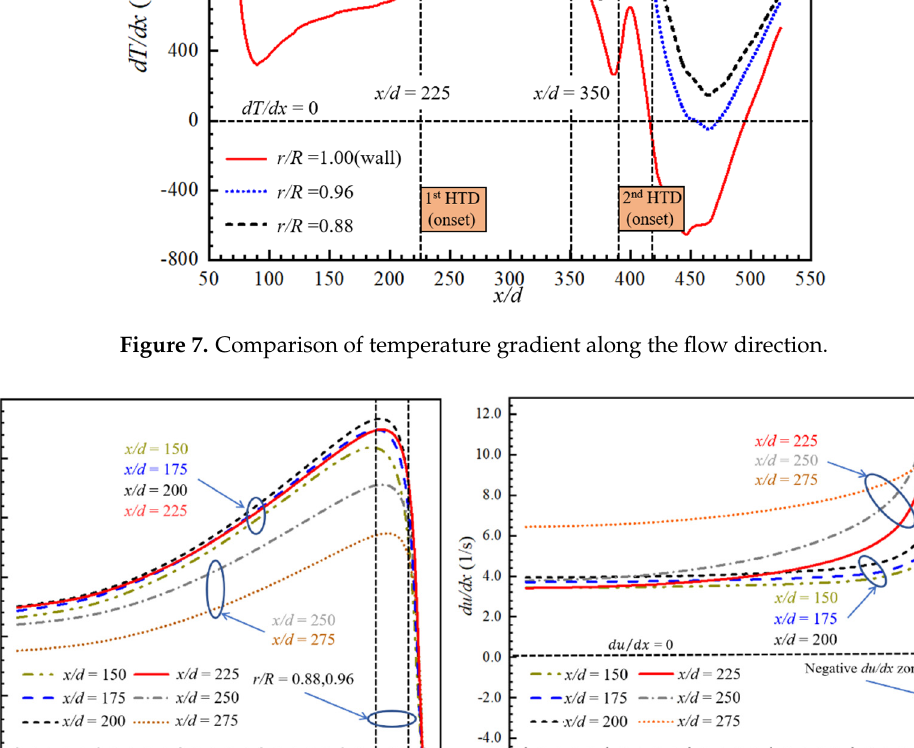
Figure 7. Comparison of temperature gradient along the flow direction.